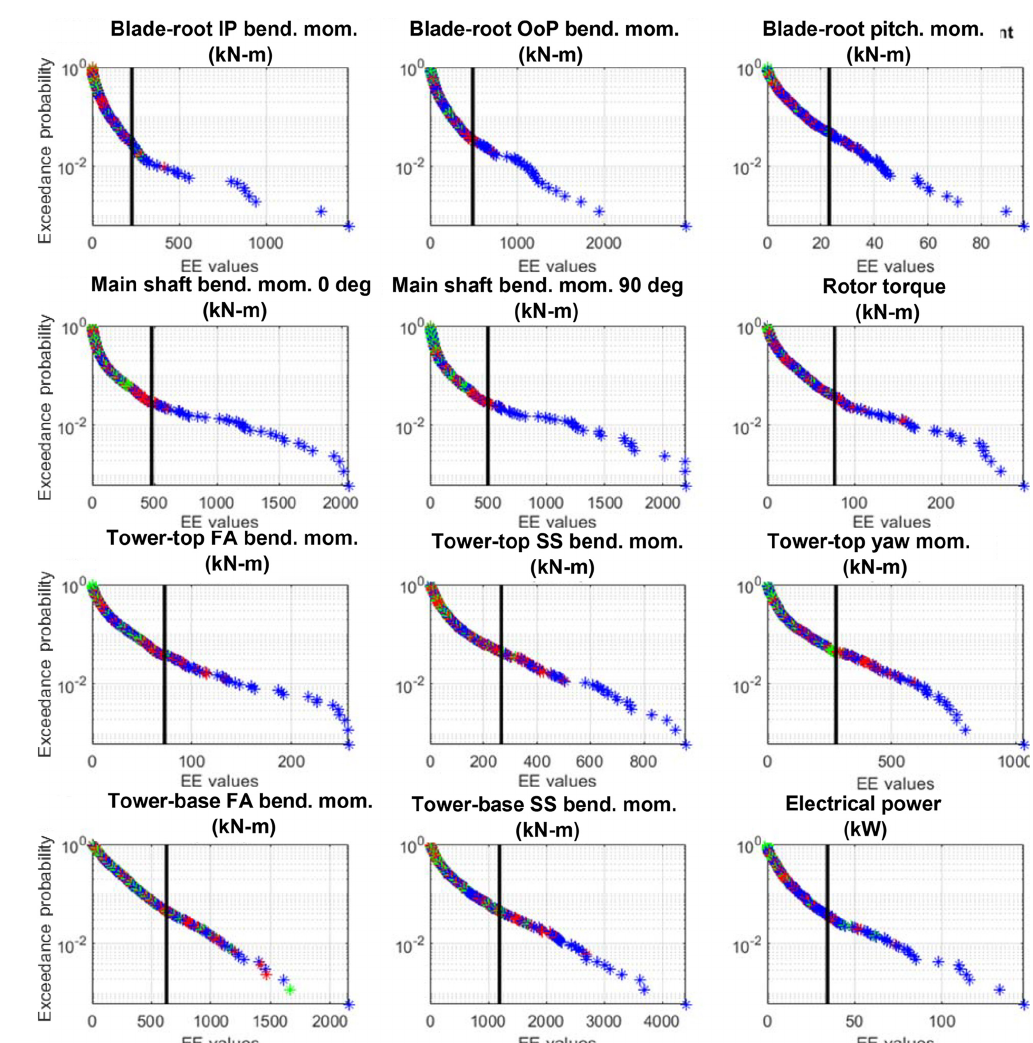
Figure B2. Exceedance probability plot of fatigue load EE values for each of the wind-inflow parameters across all wind speed bins, input parameters, and simulation points. Black line represents the defined threshold by which outliers are counted for each QoI. Color indicates wind speed bin (blue is below-rated speed, red is near-rated speed, green is above-rated speed).